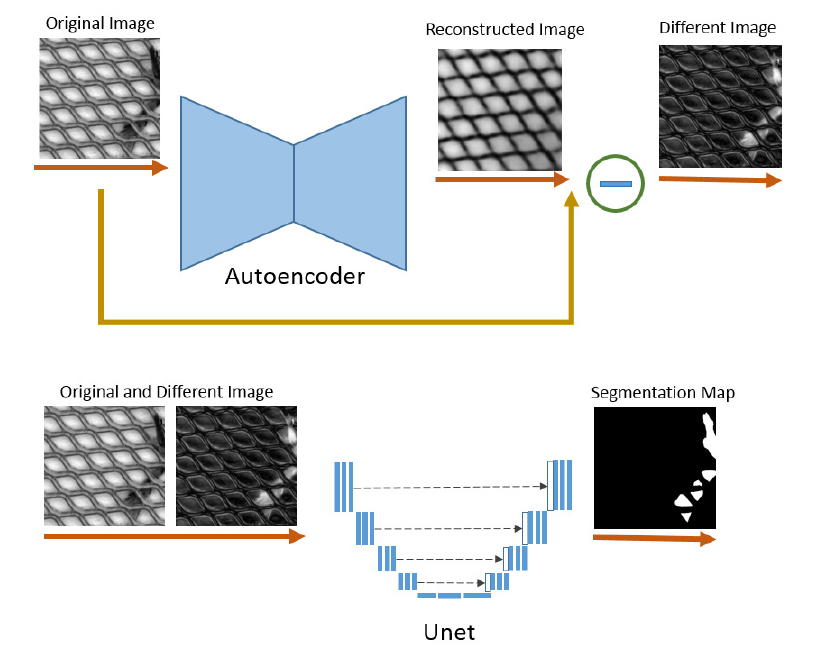
Figure 2. The overall architecture: Input unlabeled data are fed into a pre-trained autoencoder. The difference image from reconstructed and original images is then calculated. For training Unet to predict the segmentation map, both input and difference images are concatenated to obtain better